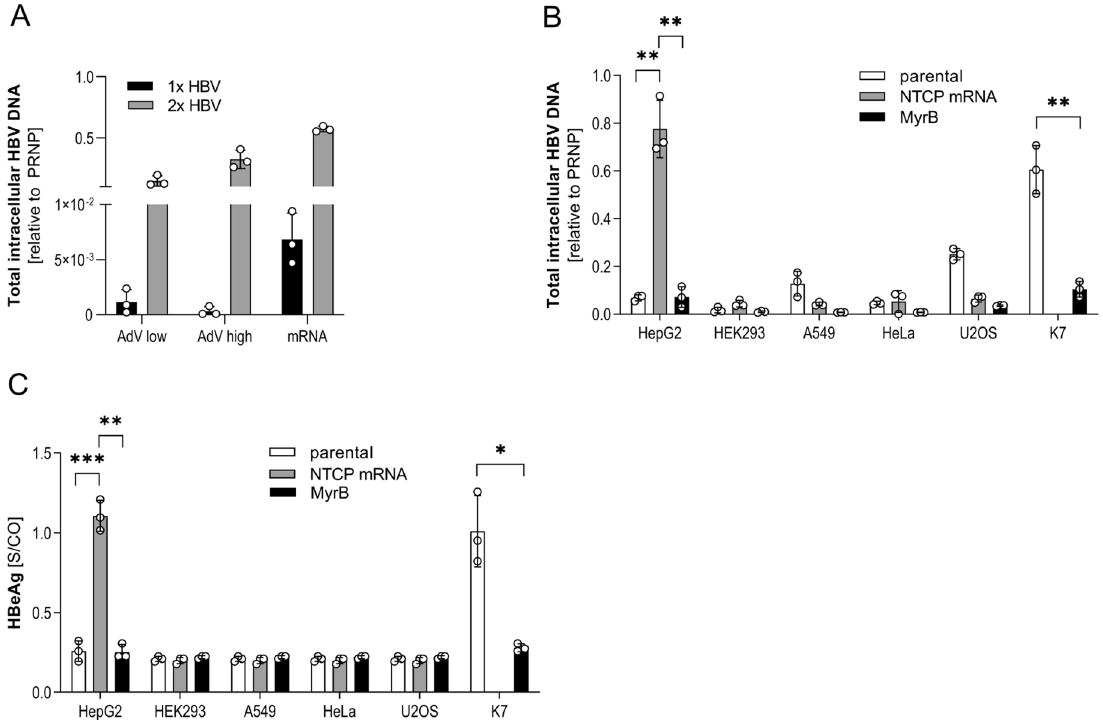
Figure 4. HBV infection in non-hepatic and hepatic cell lines. ( A ) Differentiated HepG2 cells were transfected either with 1000 ng IVT mRNA or transduced with AdV-NTCP at an MOI of 1 or 5 IU/cell, followed by the infection with HBV at an MOI of 200 virions/cell 24 h (1 × HBV) or 24 h and 72 h (2 × HBV) post transfection/ transduction. Analysis of total intracellular HBV DNA was performed 7 days post infection. ( B ) 24 h post transfection with IVT mRNA, NTCP-transfected cells were infected with HBV at MOI 200 virions/cell. Quantification of internalized HBV DNA by qPCR relative to human prion protein PRNP 6 h post inoculation. ( C ) HBeAg measurement in cell culture supernatant. HepG2-NTCP-K7 and transfected HepG2 served as positive control. Treatment with 200 nM MyrB before infection to inhibit HBV entry was applied as negative control. In all experiments, mean ± SD of three biological. Statistical significance was determined using Welsh corrected Student’s t test or two-way ANOVA. (*p < 0.05, **p < 0.01, ***p < 0.001, ****p <